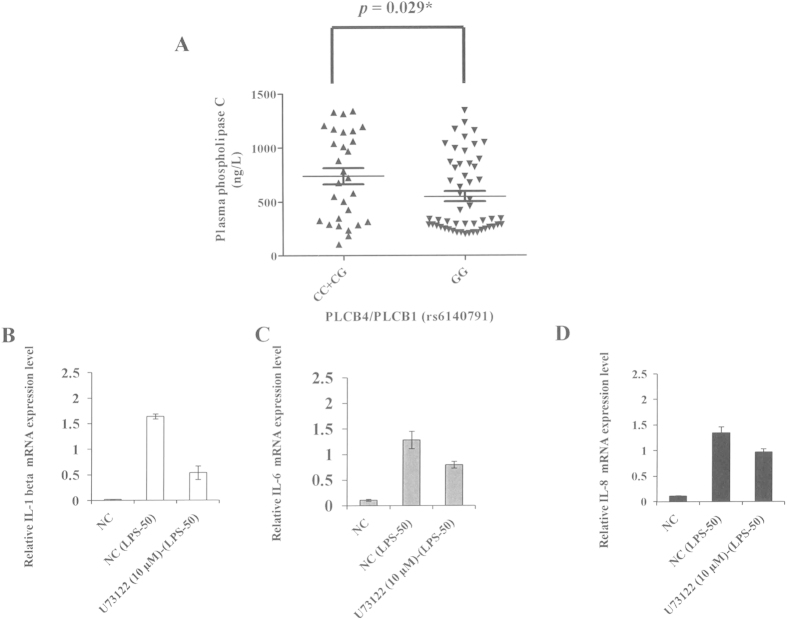
Plasma levels of phospholipase C (PLC) and the effect of a PLC inhibitor on IL-1, IL-6, and IL-8 proinflammatory cytokine mRNA expression.(A) Detection of PLC in plasma from patients with KD. PLC concentrations in plasma samples from 96 patients with KD are shown in relation to genotypes. P values were determined by student’s t test. B) HUVEC cells were treated with PLC inhibitor for 24 h followed by treatment with LPS for another 24 h. IL-1beta (B), IL-6 (C) and IL-8 (D) mRNA expression levels were quantified by RT-qPCR. Data represent means ± SD for three independent experiments.